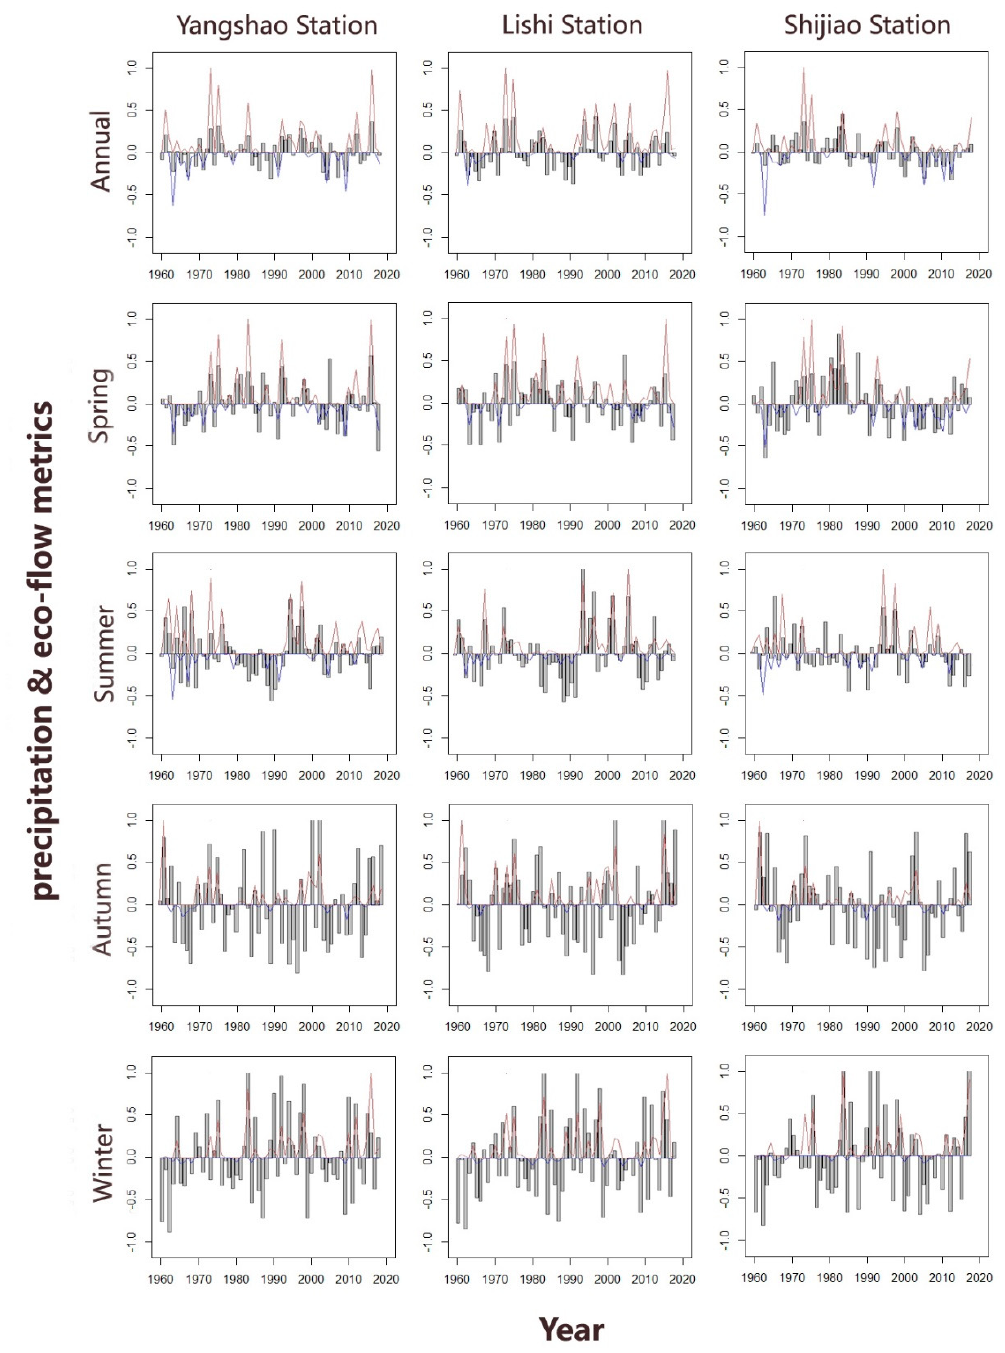
Figure 3. Yearly variations of anomalous precipitation and eco-flow metrics. Bars show anomalous precipitation and red curves show ecosurplus and blue curves show ecodeficit. The anomalous precipitation is calculated as: P anomaly = P i , where P anomaly denotes precipitation anomaly, P i denotes annual or seasonal precipitation in i th year, P denotes average of annual or seasonal precipitation.